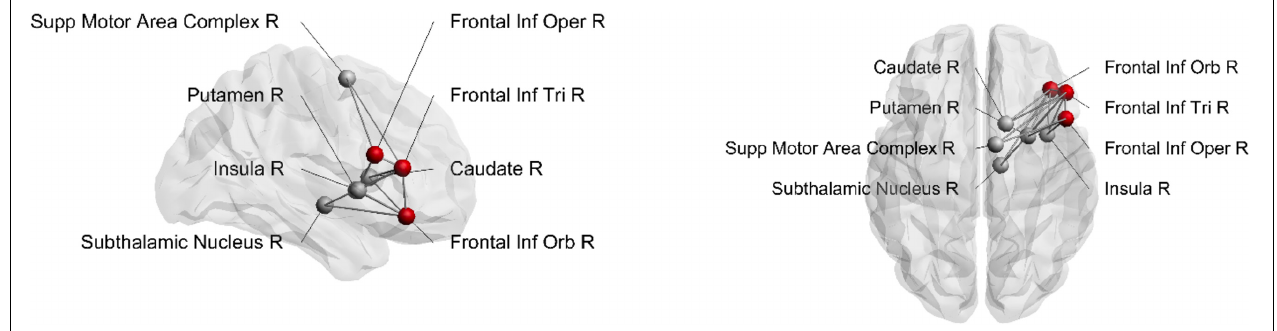
FIGURE 5 | Structural connections from rIFG subregions to the stopping network. Seeding region is marked as a red node. Inf, inferior; Supp, supplementary; Oper, opercularis; Tri, triangularis; Orb, orbitalis; R, right.